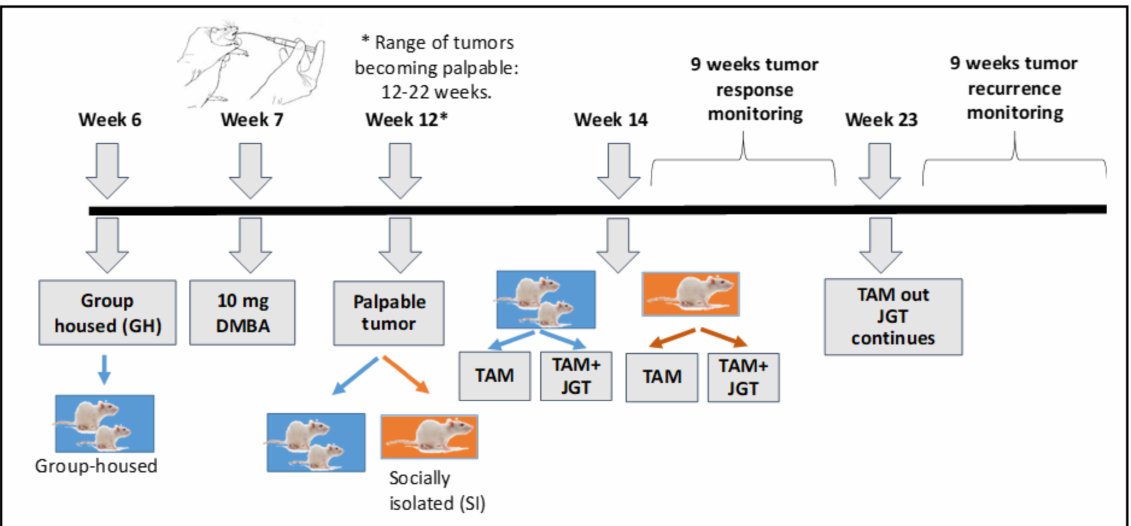
Figure 1. Experimental Design. Estrogen receptor positive (ER+) mammary tumors were induced in 50–day–old Sprague Dawley rats by orally administrating 10 mg of